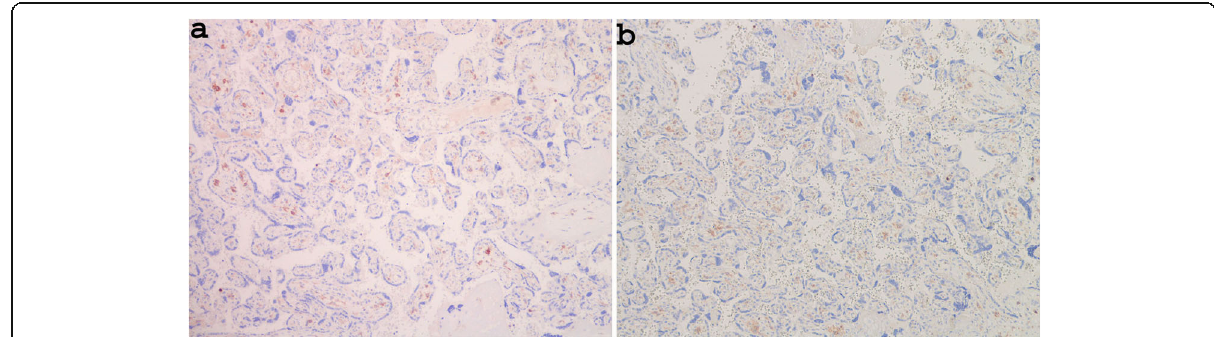
Fig. 6 Immunoreactivity for CD4 in the case control sample from a normal pregnancy, revealing the number of Hofbauer cells ( a × 100), which is the same as present in cases from a COVID-19-positive woman (Case 3, b : ×